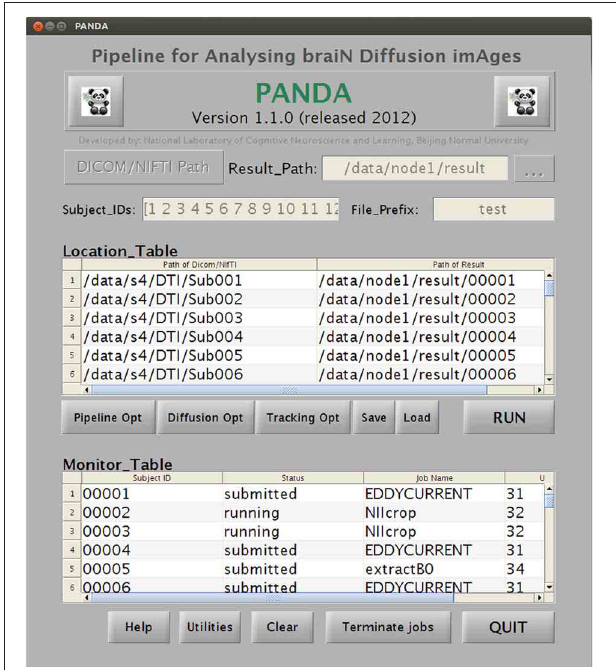
FIGURE B1 | A snapshot of the main GUI while PANDA is running. The GUI allows for (1) inputting raw dMRI datasets and configuring processing parameters and (2) monitoring the progress of data processing in